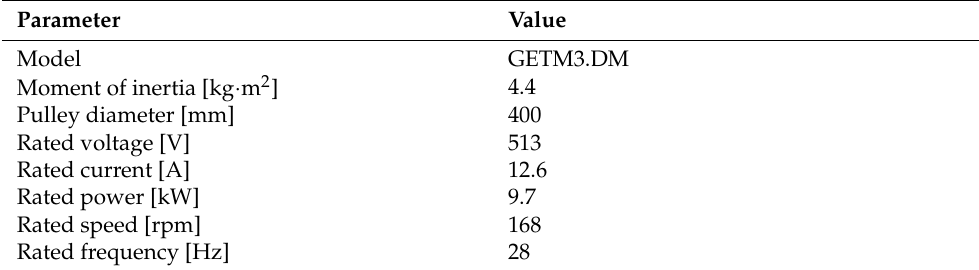
Table 1. Parameters of elevator traction